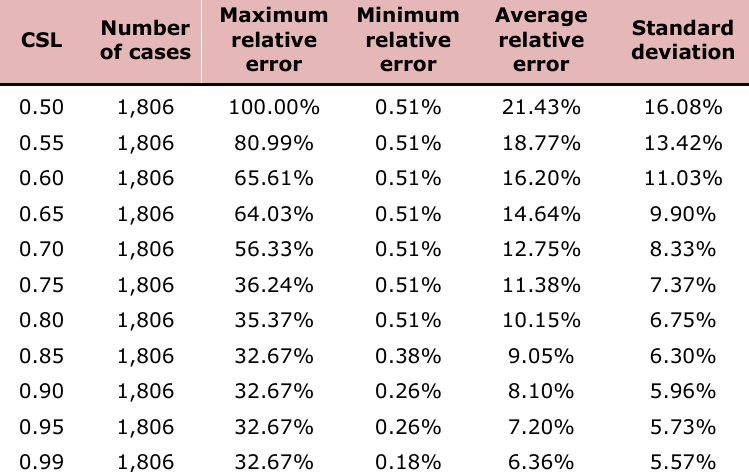
Table 2. “Maximum, minimum, average and standard deviation of relative